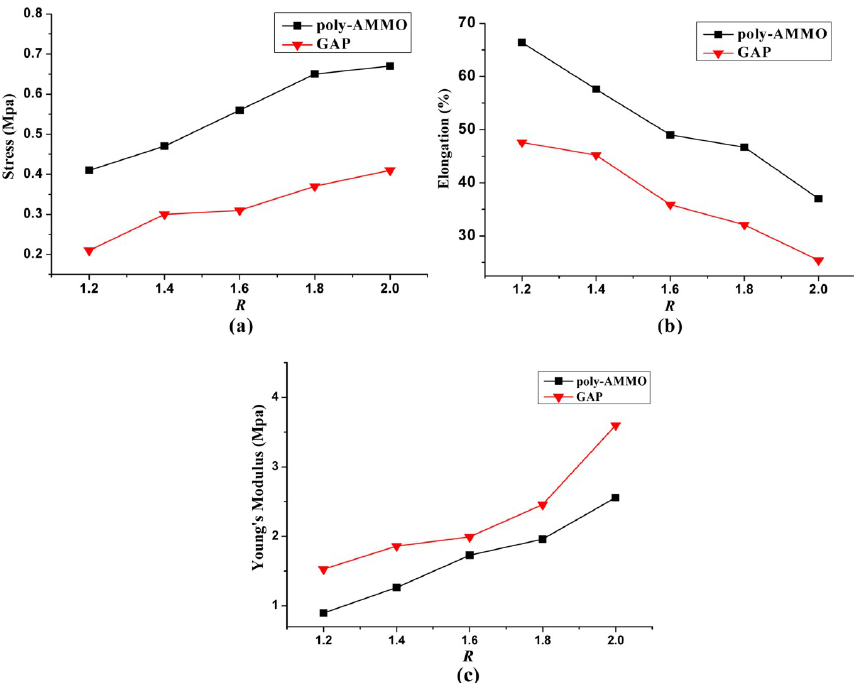
Figure 13. ( a ) Effect of R on the tensile strengths, ( b ) Effect of R on the elongation at break, ( c ) Effect of R on the Young’s Modulus. Reprinted with permission of John Wiley & Sons from